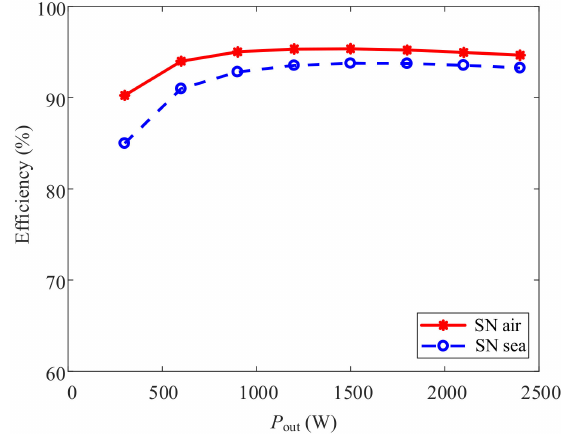
Figure 11. System efficiency varying with P out